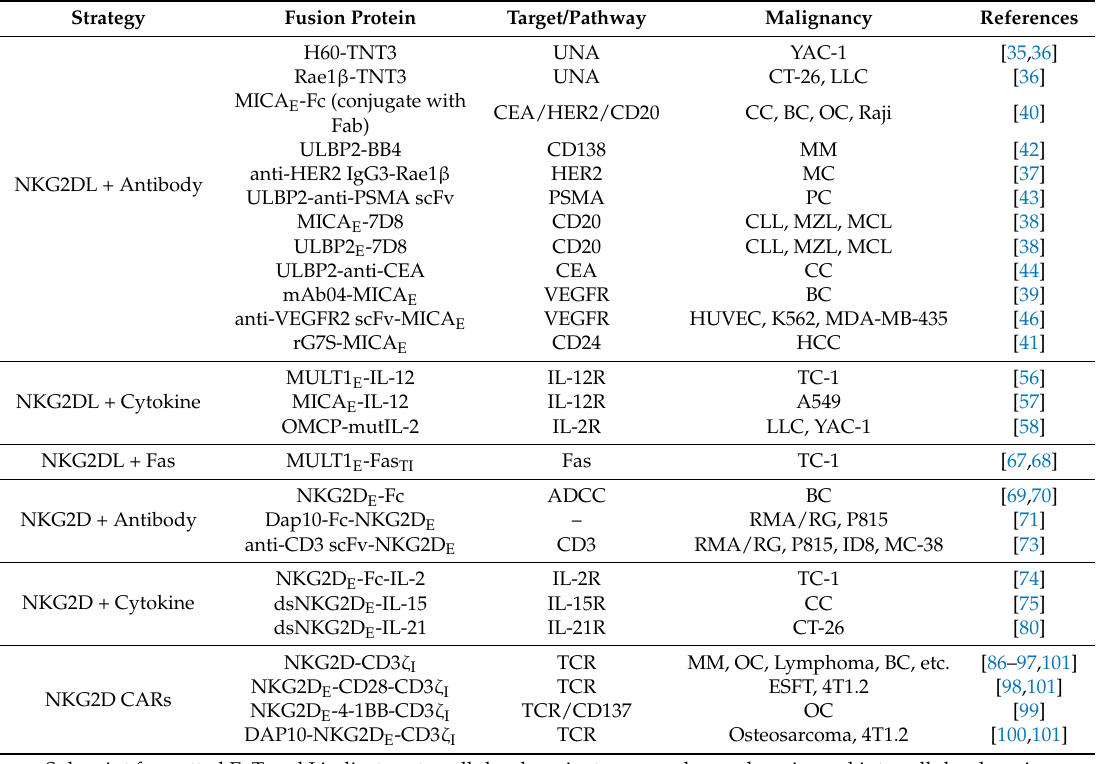
Table 1. Fusion proteins of NKG2D/NKG2DLs in cancer